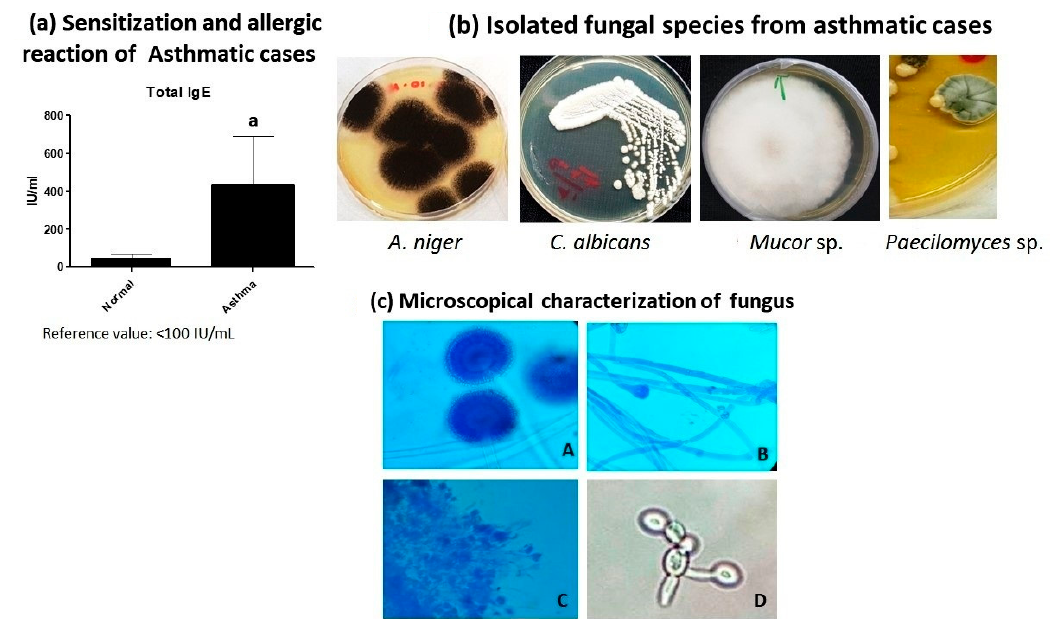
Figure 1. ( a ) Total immunoglobulin E (IgE), sensitization, and allergic reactions of asthmatic cases; ( b ) isolated fungal species from asthmatic cases; ( c ) microscopical characterization of fungus with lactophenol cotton blue mount: A, Aspergillus niger ; B, aseptate hyphae and young conidiophores of Mucor sp; C, Paecilomyces sp.; D, germination tube test positivity of Candida albicans. Results are means ± SD. The letter a above the average bar denotes a significant difference with the normal at p < 0.05 using Tukey’s test. Table 1. Antifungal activity of ethanolic factions of marine macroalgae.